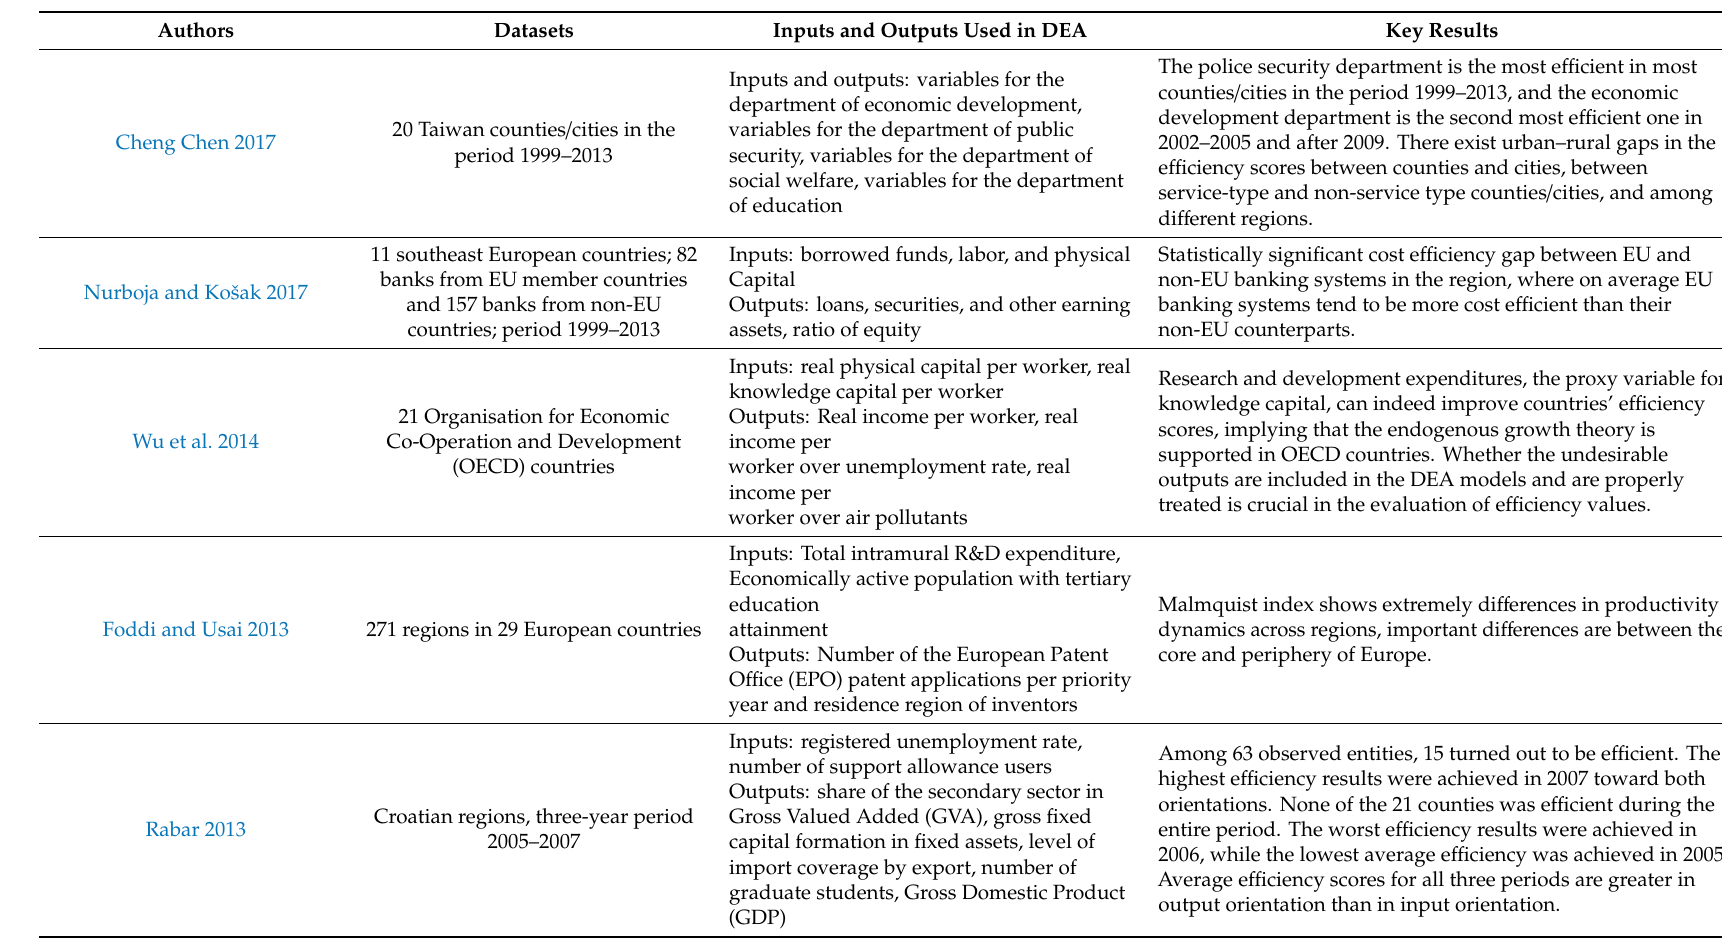
Table A1. DEA method in countries’ macroeconomy and KBE studies (source: own review and